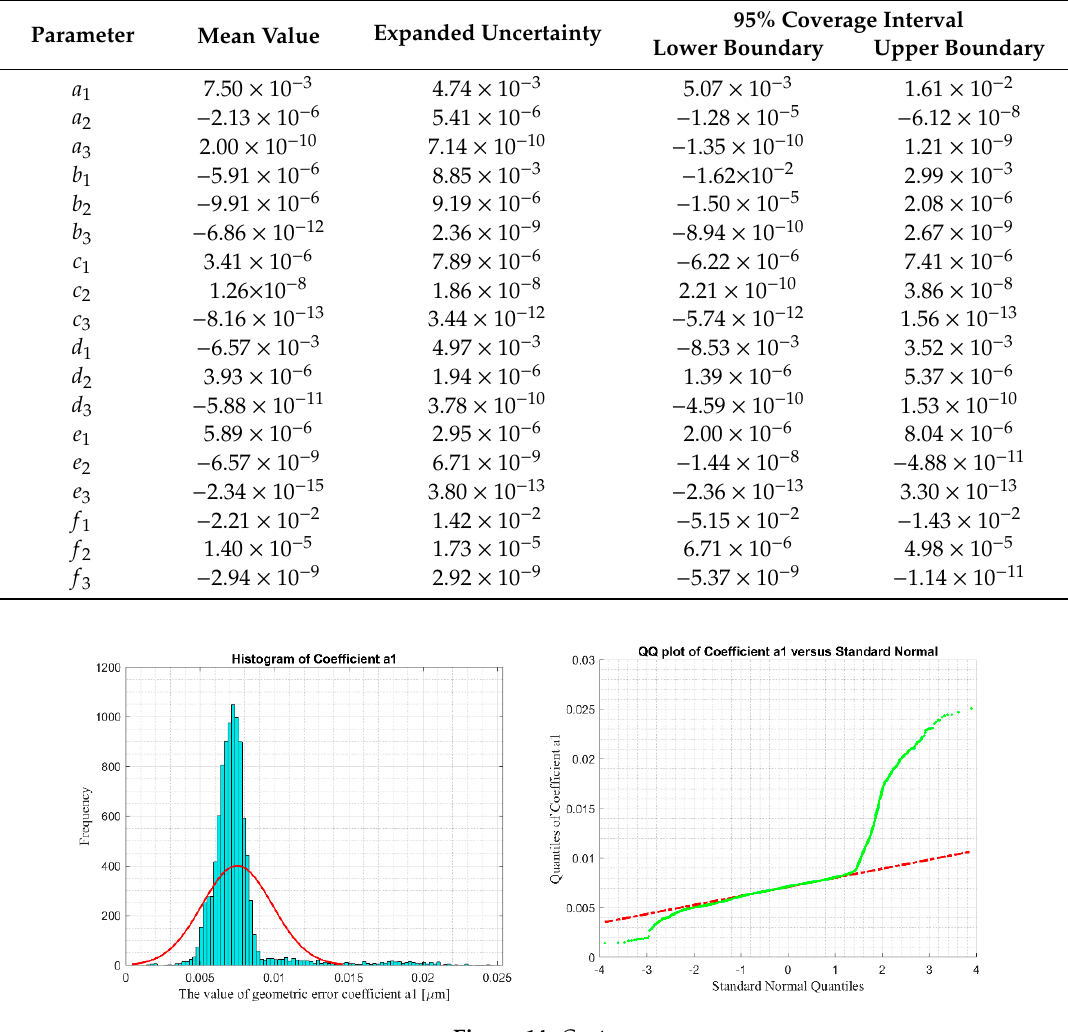
Table 3. Parameters of the coefficients of the mathematical models for lateral geometric error correction.